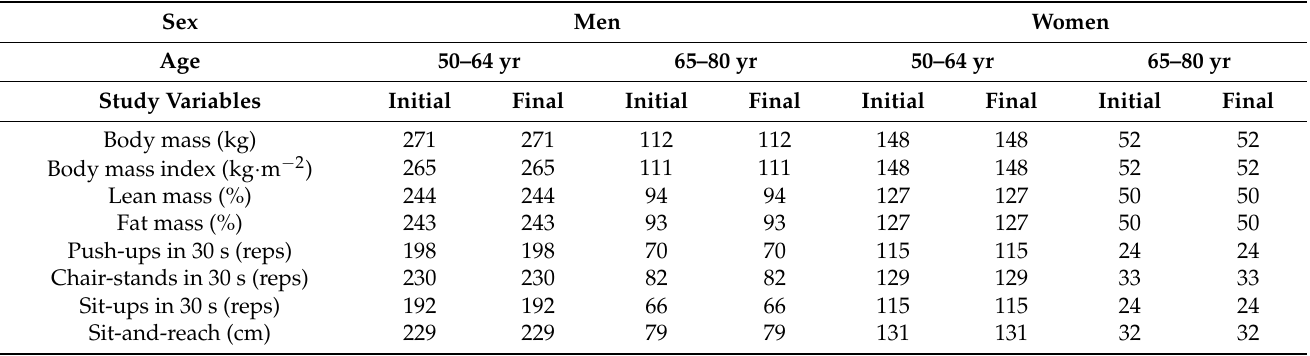
Table 1. The number of the participants ( N ) with both initial and final measurement, according to sex (men/women) and age in years